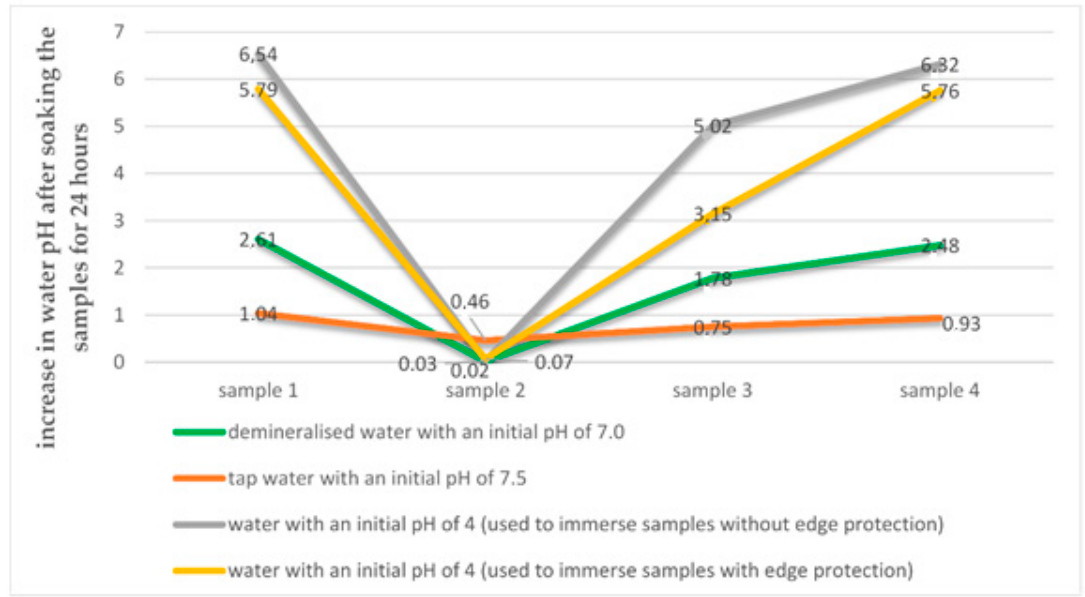
Figure 5. Trends of water pH change during 24 h soaking of polymer modified bituminous thick coatings.